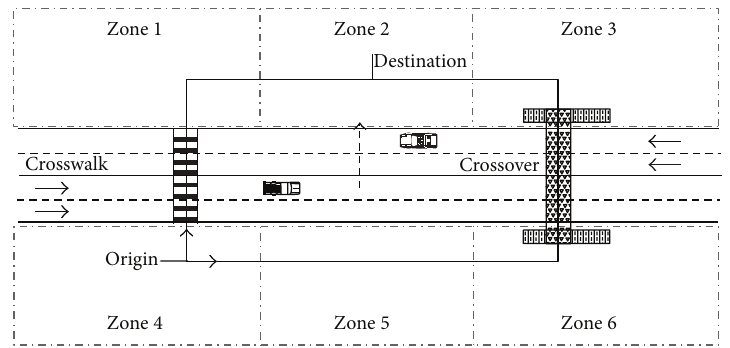
Figure 1: Illustration of crossing